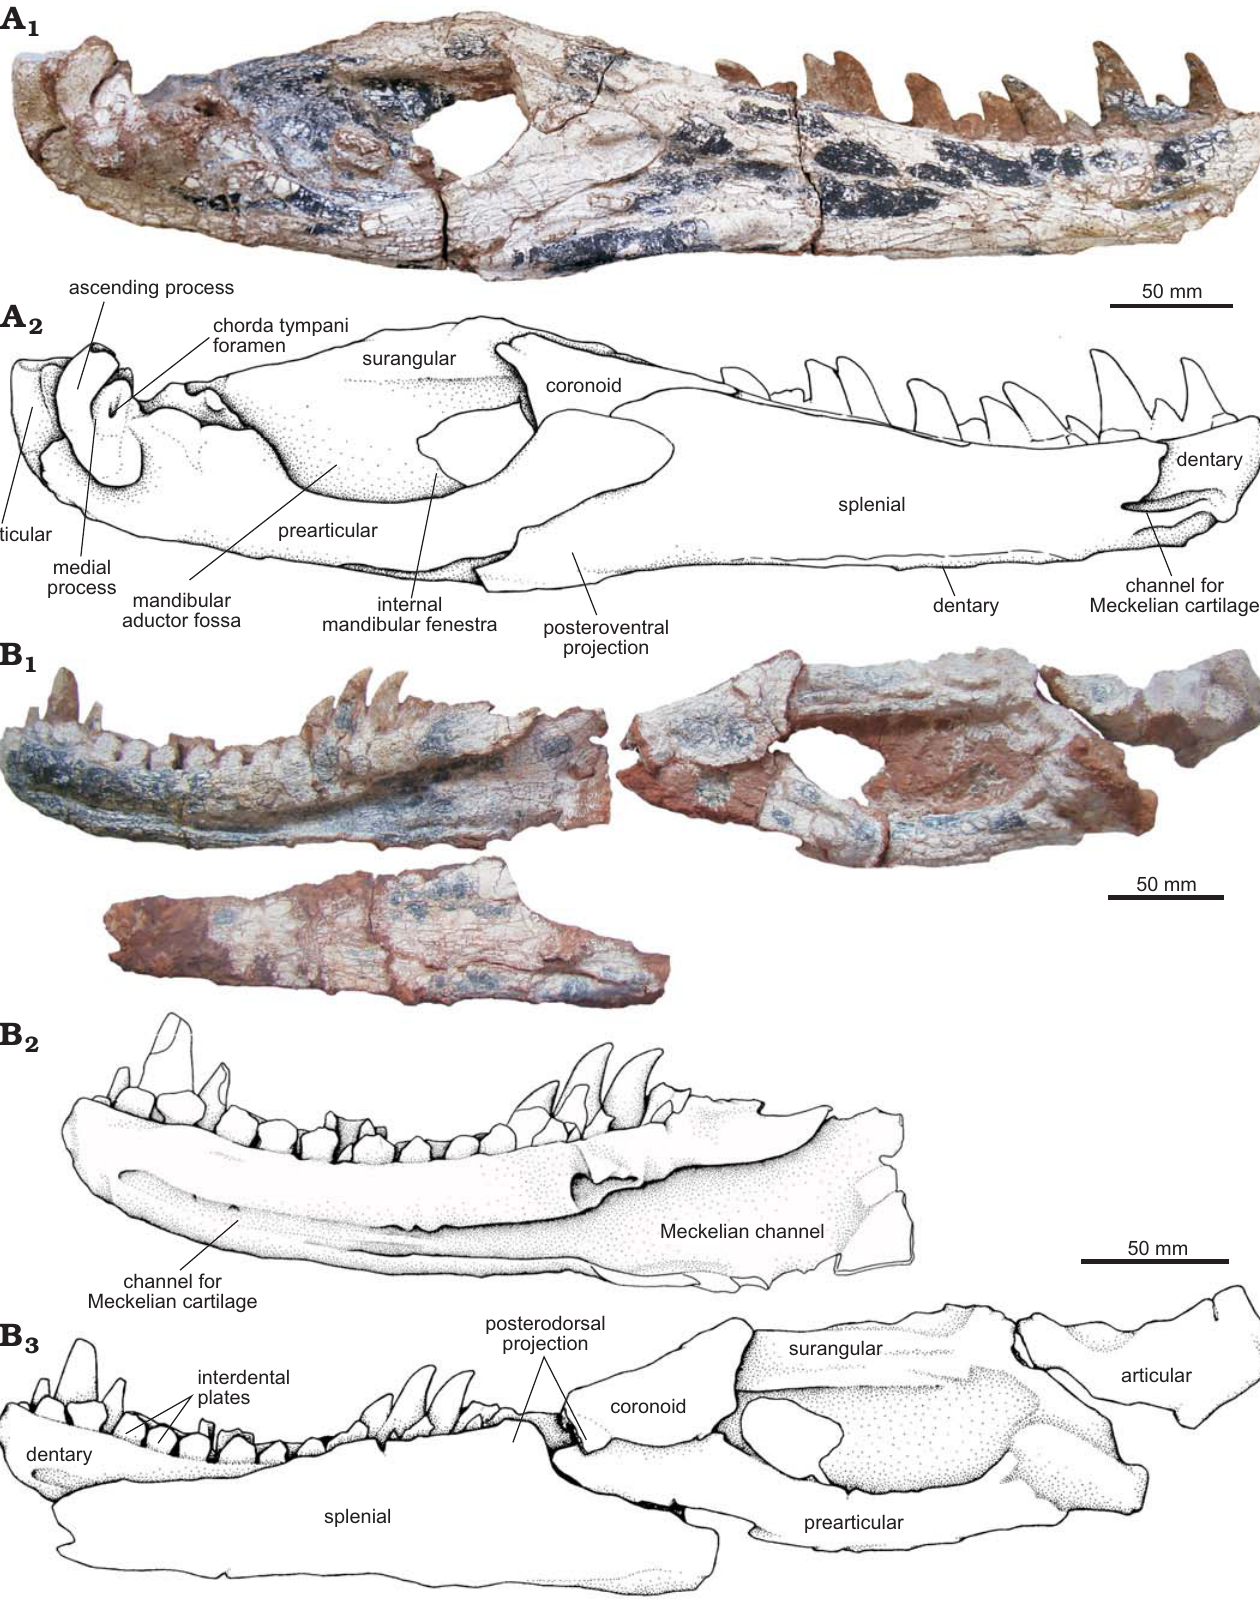
Fig. 17. The pseudosuchian archosaur Prestosuchus chiniquensis Huene, 1938 (UFRGS-PV-0629-T) from the Dinodontosaurus Assemblage Zone, Ladinian, Middle Triassic, Dona Francisca municipality, Rio Grande do Sul State, Brazil; medial view of the left ( A ) and right ( B ) mandibles. Photographs (A 1 , B 1 ) and explanatory drawings (A 2 , B 2 , B 3